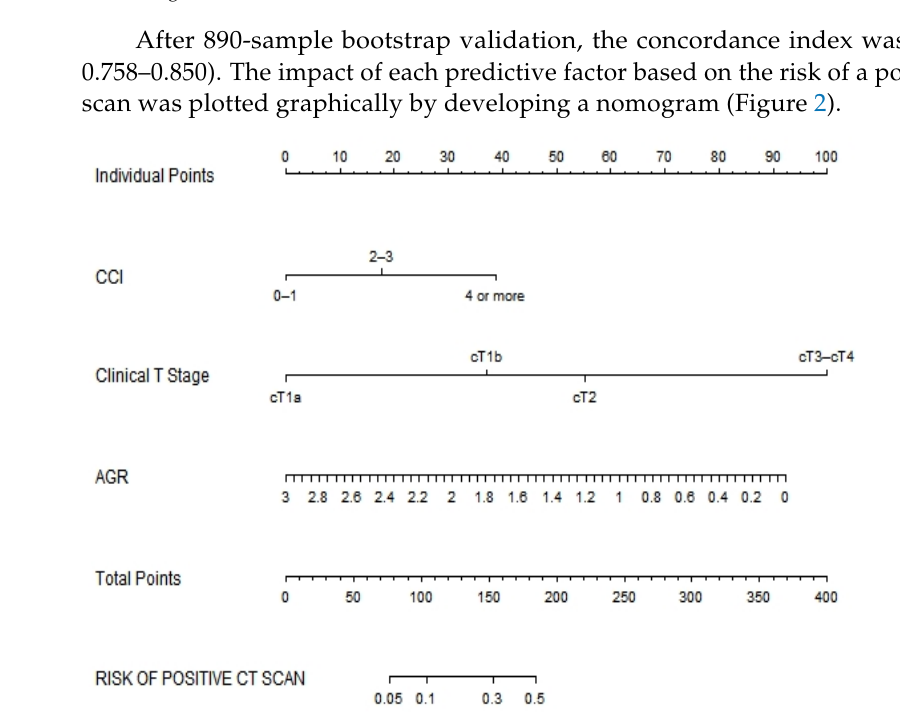
Figure 2. Nomogram predicting the risk of pulmonary metastasis in 890 patients with renal